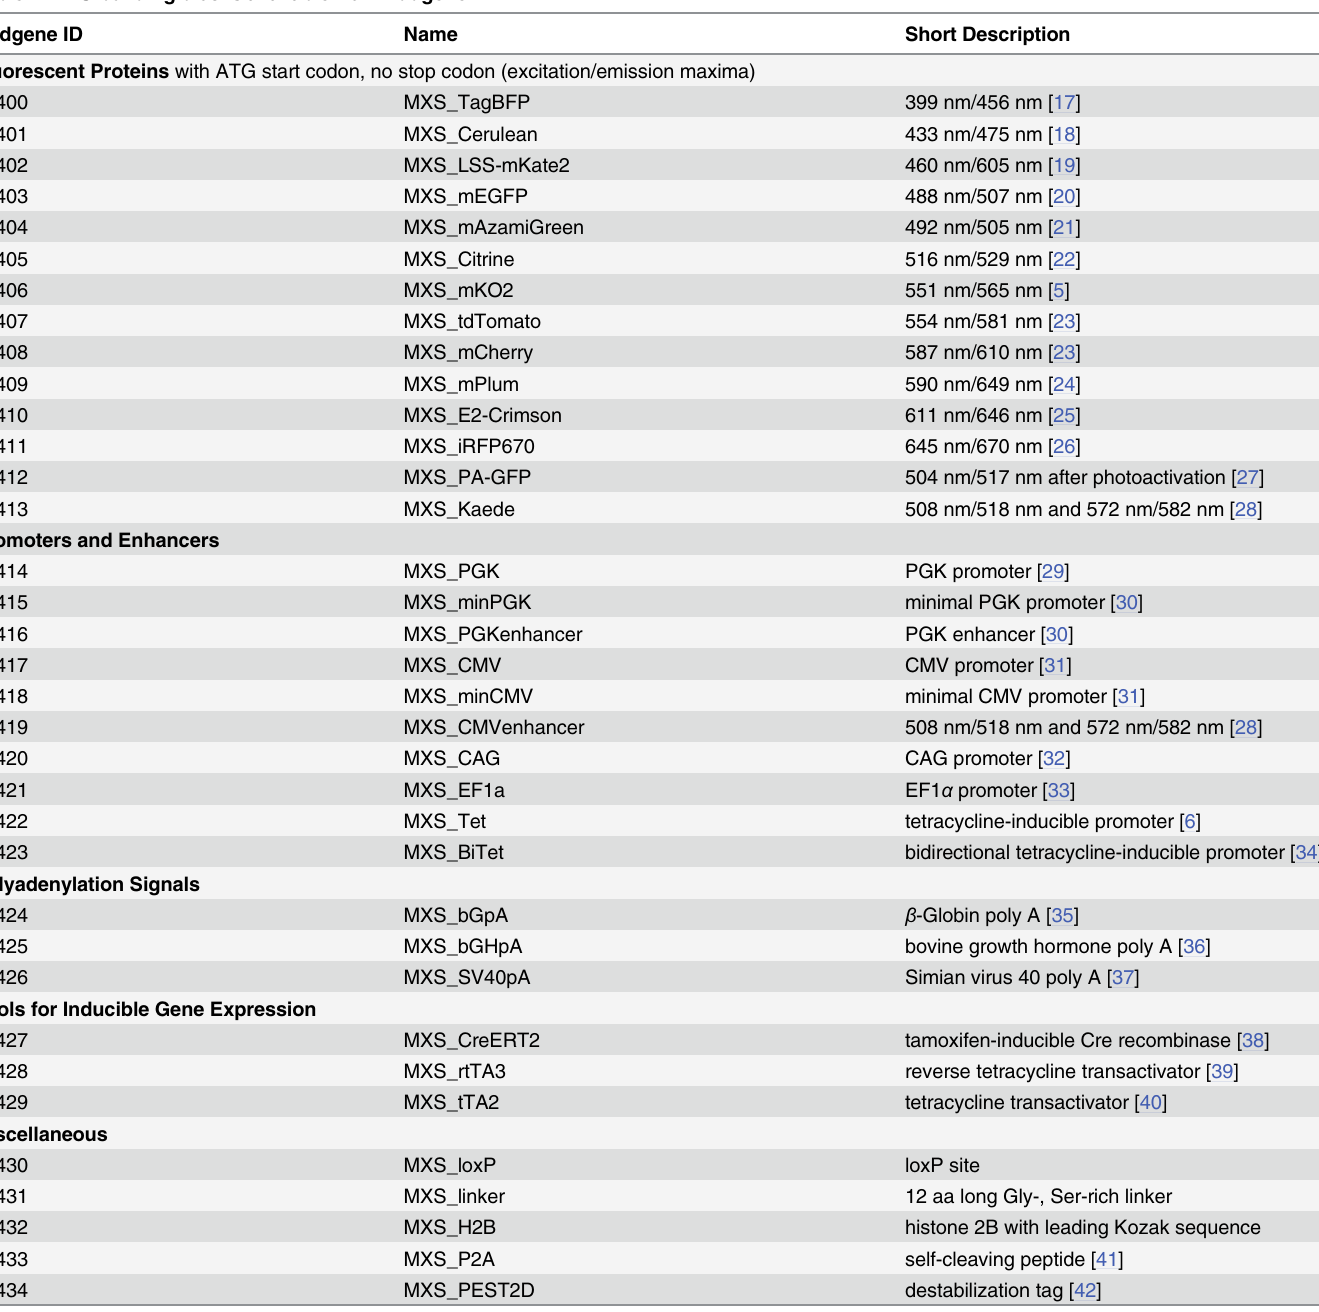
Table 1. MXS-building blocks available from Addgene. Addgene